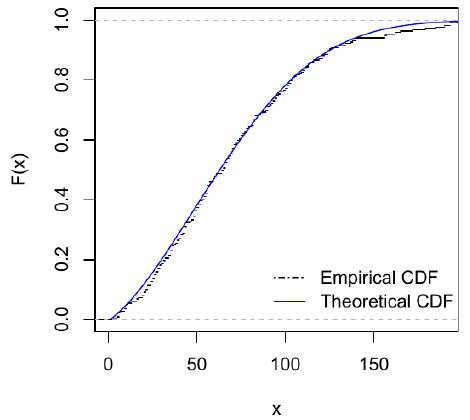
Figure 10. Empirical and fitted EHSN cdf for volcano heights in dataset